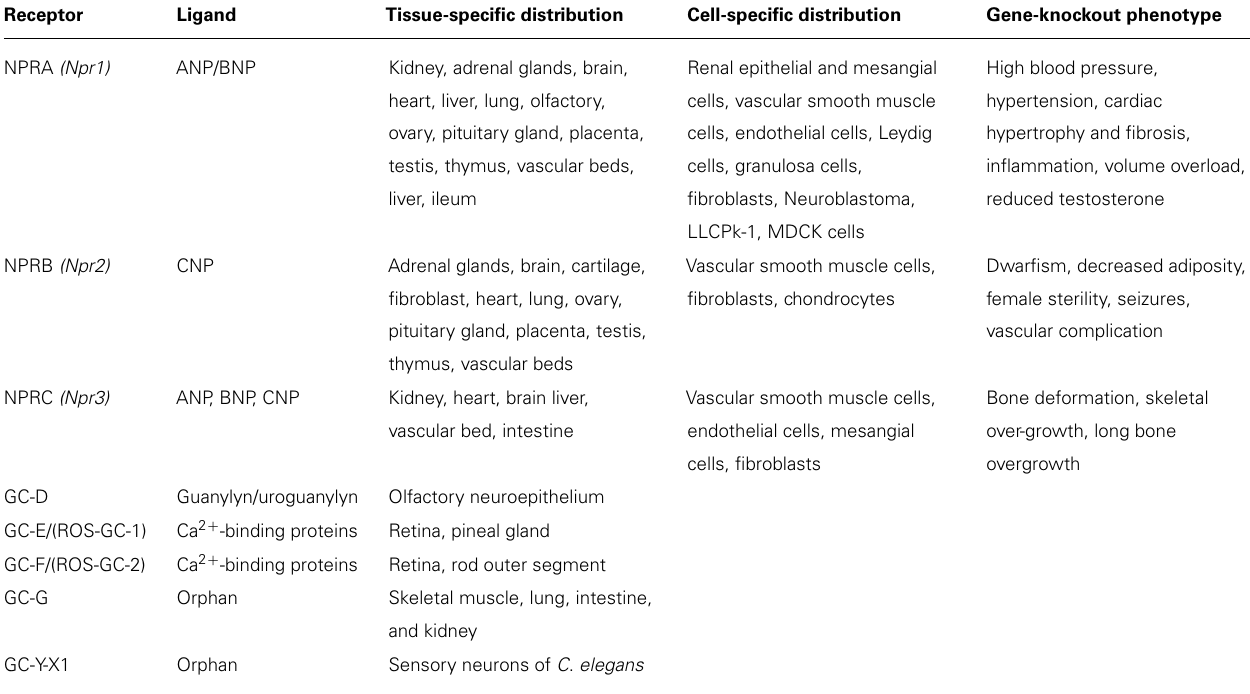
Table 2 |The distribution of natriuretic peptide receptors (NPRA, NPRB, and NPRC) and their gene-knockout phenotype. Receptor Ligand Tissue-specific